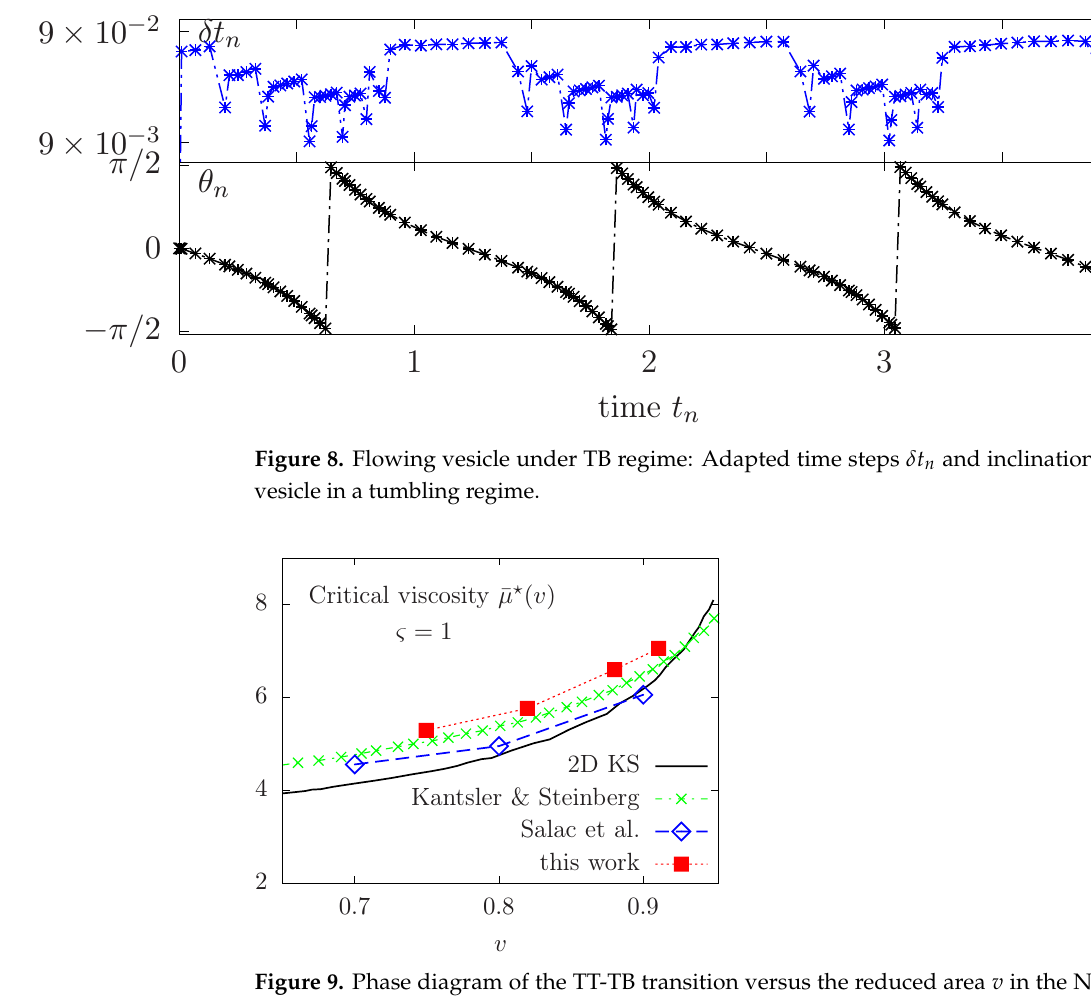
Figure 9. Phase diagram of the TT-TB transition versus the reduced area v in the Newtonian case. Comparison with 2D KS theory [50], experimental results of Kantsler & Steinberg in [51] and numeri- cal computations in [26]. [Colour figure can be viewed